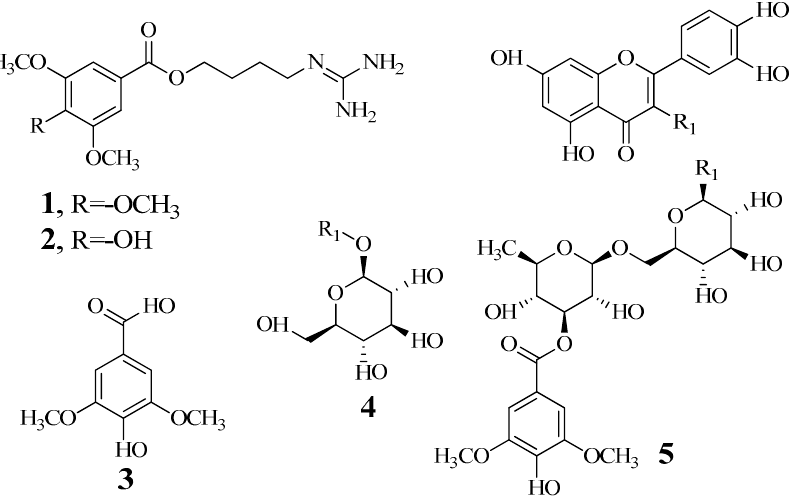
Figure 1. The structure of components 1 – 5 from Leonurus japonicas .